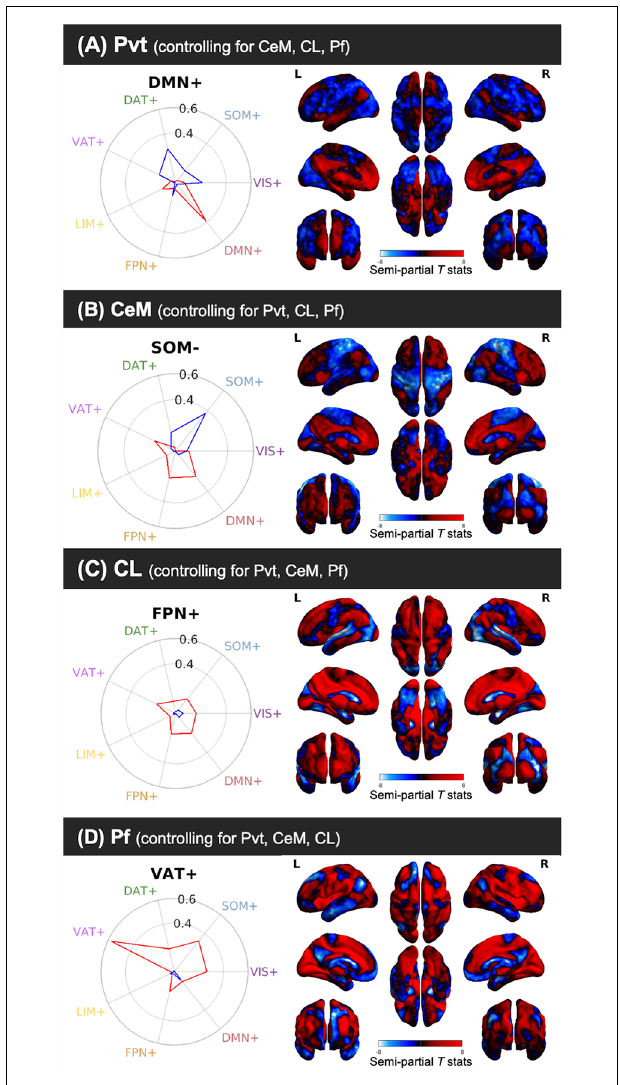
FIGURE 5 | Cosine similarity between binary vectors representing a 7-Network Parcellation of large-scale functional networks (Thomas Yeo et al., 2011) and the positive FC (red) and negative FC (blue) patterns for the semi-partial correlation statistics for the PVT, CeM, CL, and Pf. Polar plots are shown on the right and the unthresholded semi-partial correlation maps are shown on the right. (A) The PVT showed the highest cosine similarity with the DMN+/DAT-. (B) The CeM positive FC also showed correspondence with the DMN+, although numerically weaker than the PVT. The CeM negative FC best matched with SOM-. (C) The CL positive FC map did not show a strong cosine similarity with any of the known large-scale intrinsic networks, but was numerically best-matched with the FPN+. (D) The Pf showed the strongest cosine similarity with the VAT+. Abbreviations: DAT, dorsal attention network; DMN, default mode network; FPN, fronto-parietal network; LIM, limbic network; SOM, somato-motor network; VAT, ventral attention network; VIS, visual network.